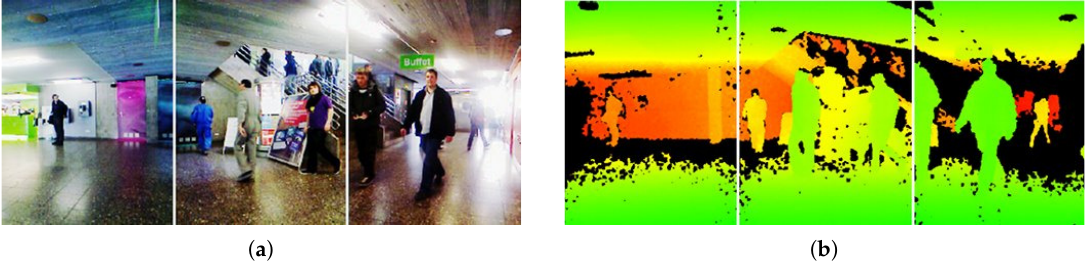
Figure 22. Examples from the RGB-D People Dataset. The figure shows the color image data ( a ) and the dense depth data ( b ) of three examplar frames. The figure is originally from the website